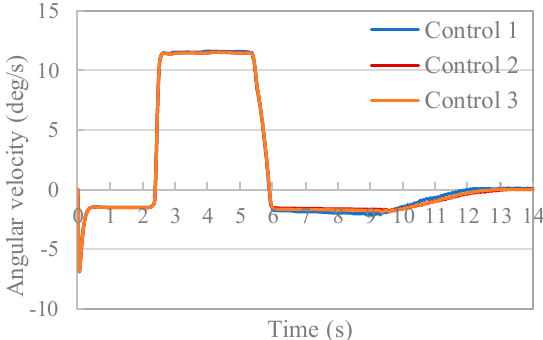
Figure 21. Time history of angular velocity.